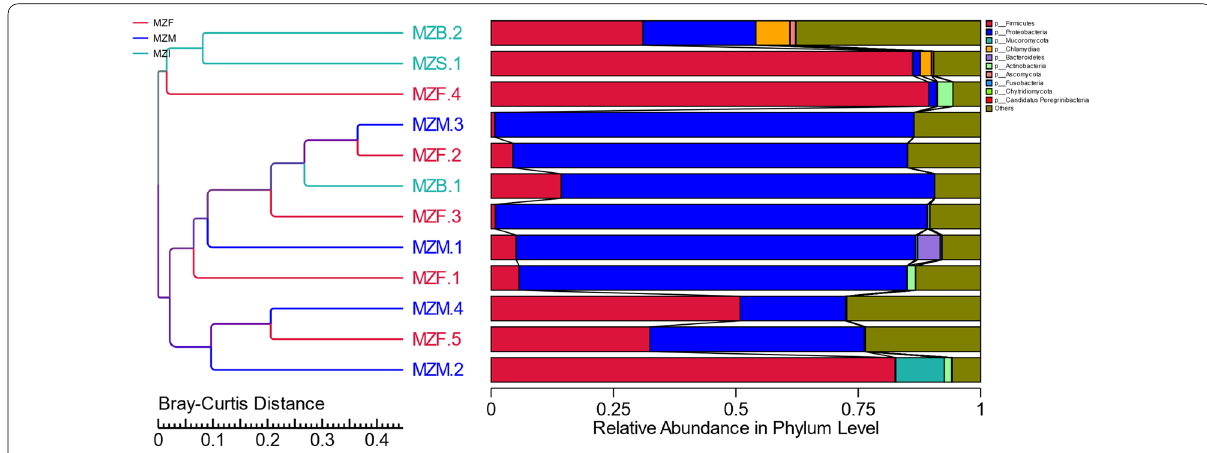
Fig. 2 Relative abundance of gut bacterial at the phylum taxonomical